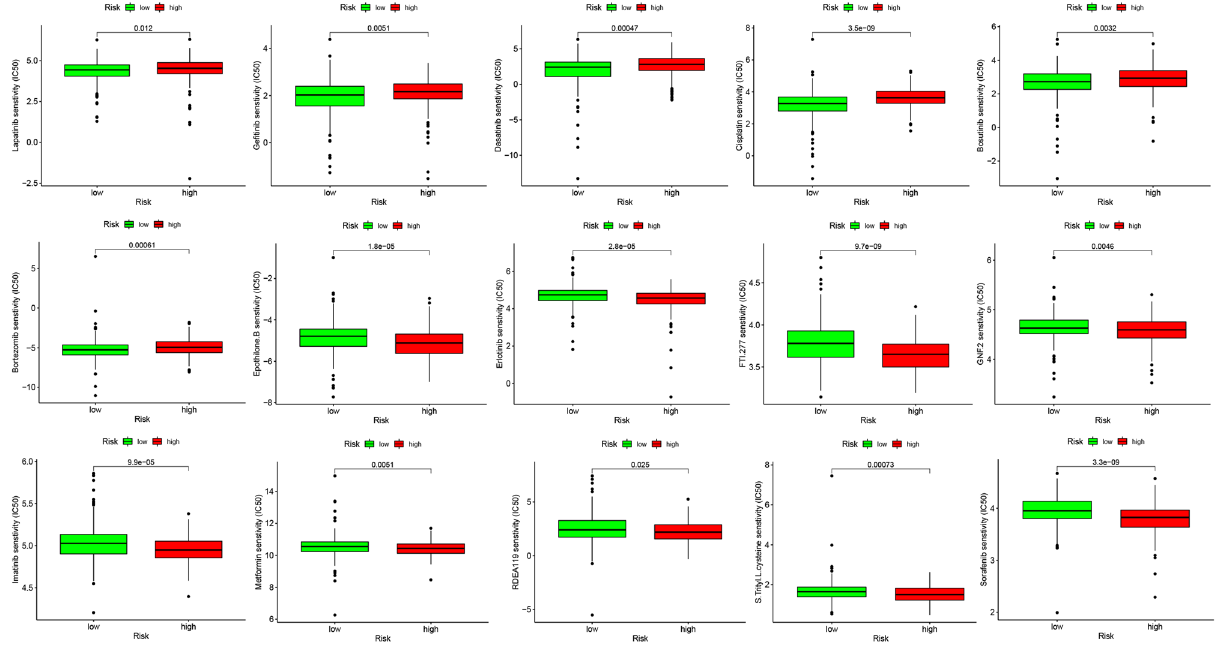
Figure 8. Correlation analysis of melanoma risk score and chemotherapy drug